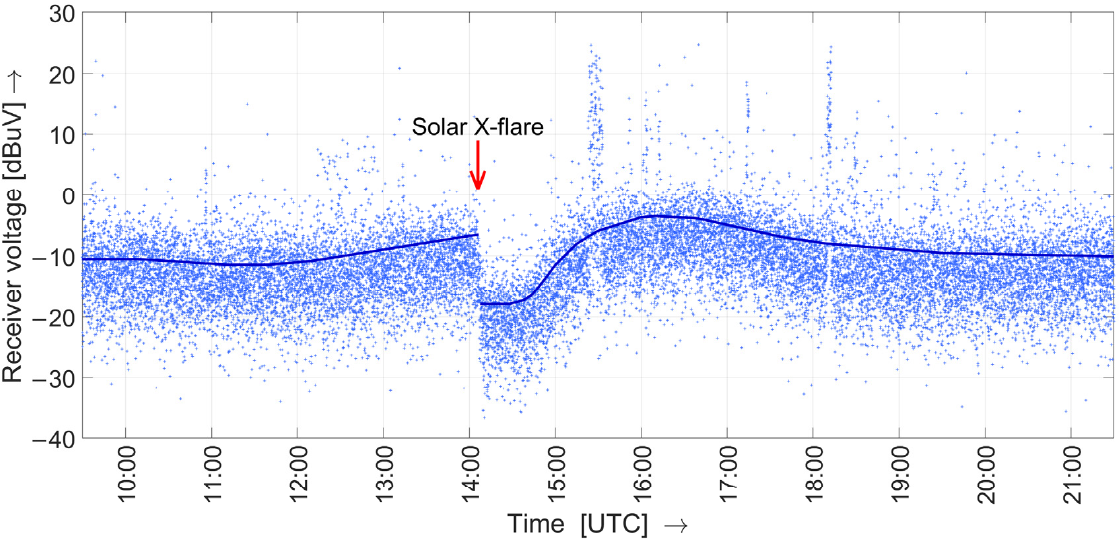
Figure 1. Measured ambient noise levels drop of approximately 12 dB in a remote rural location during the impact of a solar X-ray flare which causes the ionospheric D-region to become absorptive. According to the National Oceanic and Atmospheric Administration (NOAA), based on observations in the 0.1–0.8 nm spectral band, this class of X1.6 solar flare started 22 October 2014, 14:02 UTC, peaked at 14:28 UTC and ended at 14:50 UTC. Reprocessed measurement data from [20].